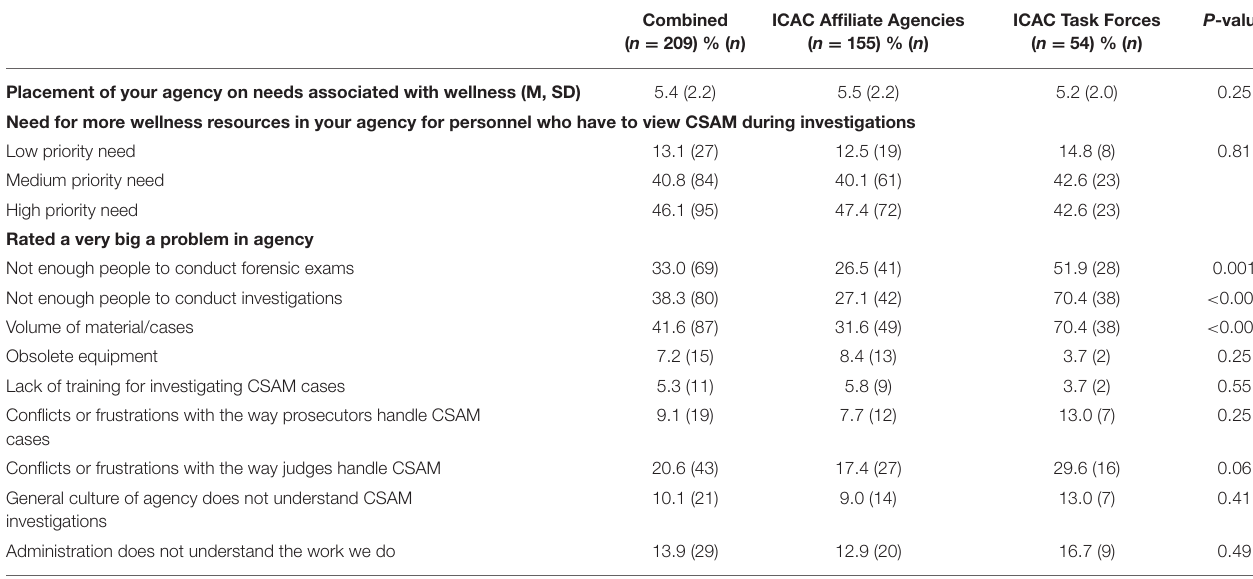
P -value Combined ICAC Affiliate Agencies ICAC Task Forces ( n = 209) % ( n ) ( n = 155) % ( n ) ( n = 54) % ( n )